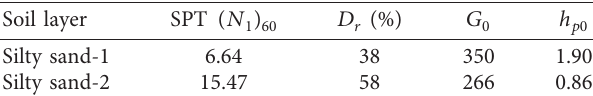
Table 3: The parameters for the PM4sand model [10].